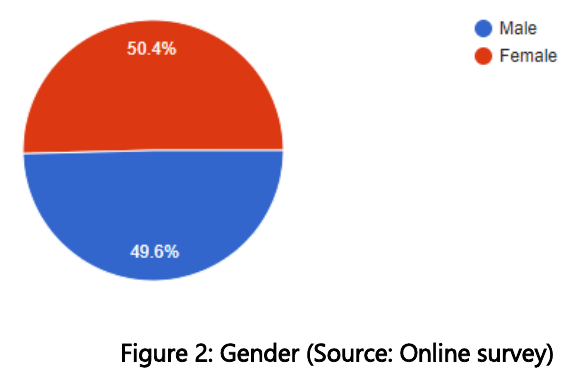
Figure 2: Gender (Source: Online survey)